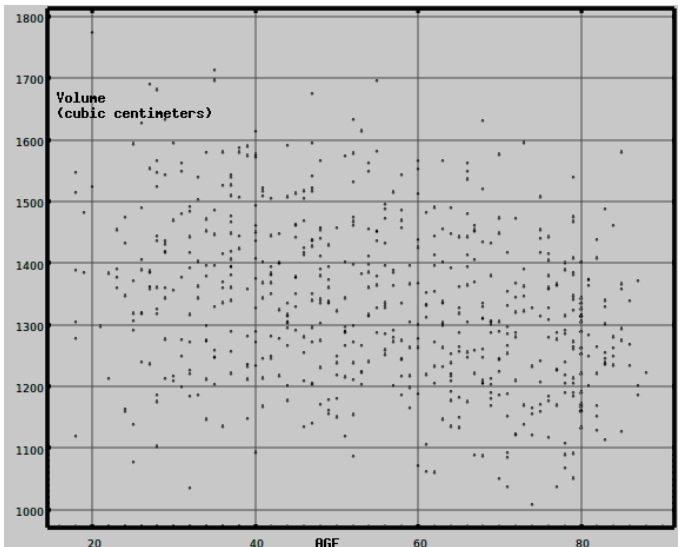
Figure 7. The brain volume for each subject was obtained using Freesurfer (see text). Brain volume for this normative cohort shows the expected decrease with age [23] beginning at about age 60. Over the full age range, the Pearson’s correlation between brain volume and age is − 0.295, df = 617, p < 10 − 18 .